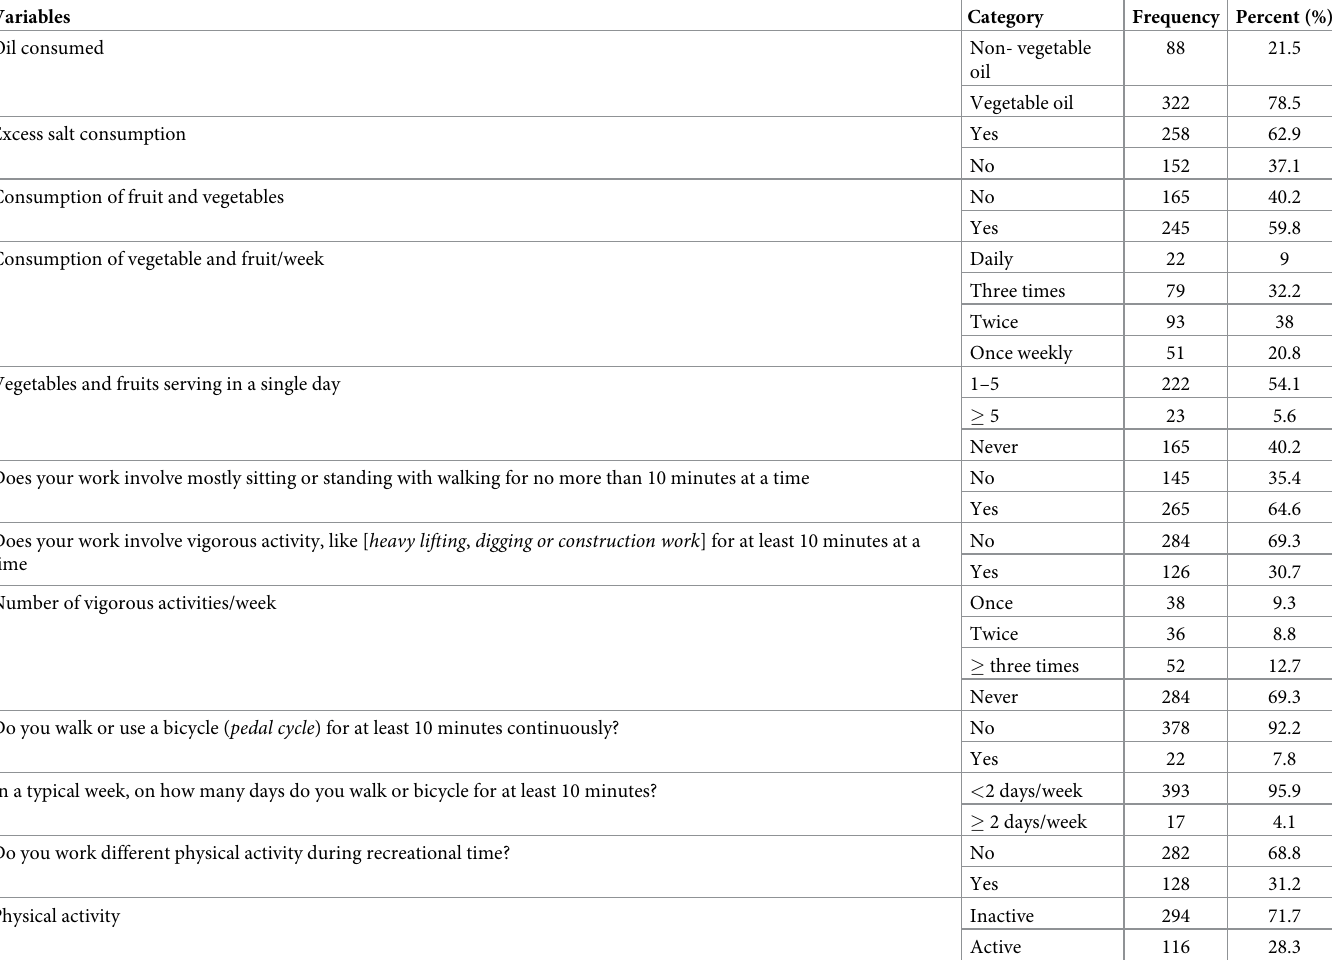
Table 3. Physical activity and dietary patterns characteristics of the governmental employees in East Guji Zone, Southern Ethiopia,